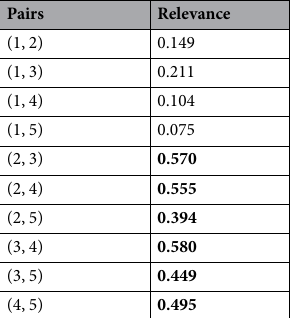
Table 3. Relevance of community pairs in the Tohoku network. Pairs represent the community pairs in the network and are indicated by their